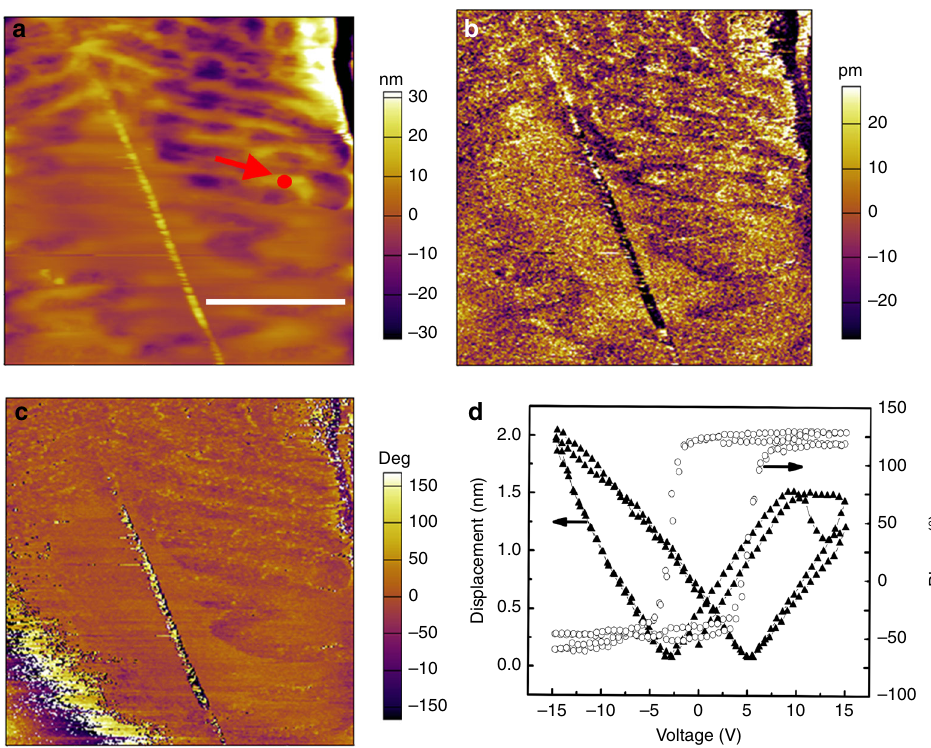
Fig. 3 PFM of 2D-BP. a The morphology image. The scale bar is 2 µ m. b The amplitude image. c The phase image. d Hysteresis loop